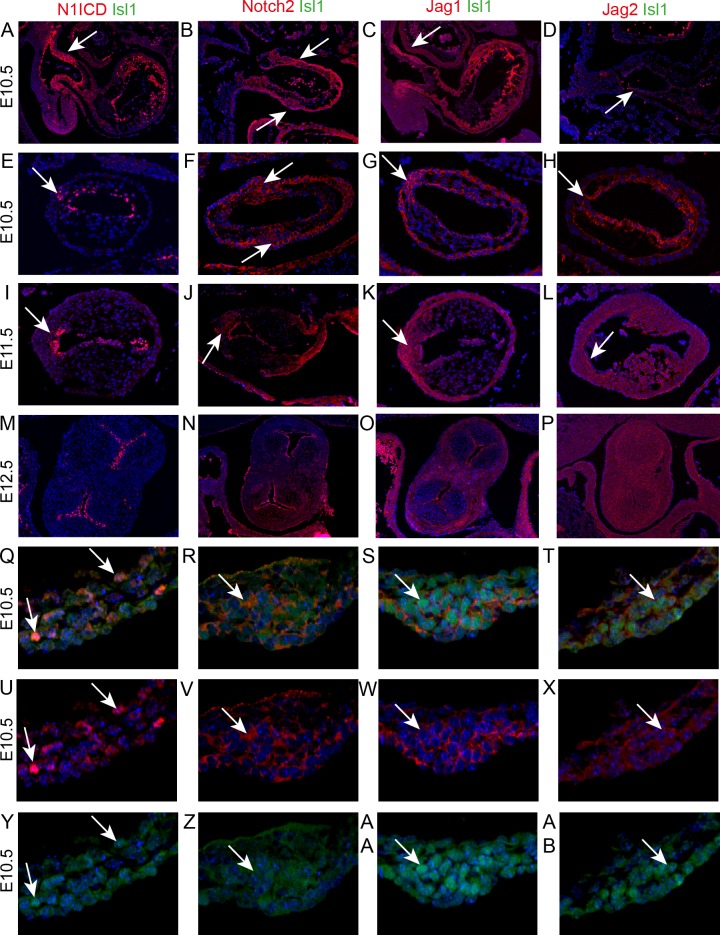
Notch signalling is found in the developing ICVS.All sections are frontal unless otherwise stated. Images are typical examples from a minimum of n = 3 at each stage. In E-AB, arrows point to the ICVS. (A–D) Sagittal sections show that Notch1ICD, Notch2 and Jag1 are abundant in the distal outflow wall (arrows) at E10.5. Jag2 is only found in the endothelium (arrow in D). (E–L) Notch1ICD, Notch2, Jag1 and Jag2 are found in the endocardium overlying the main cushions, but not within the cushions themselves at E10.5–11.5. All four localise to the ICVS at E10.5, with Notch1ICD, Notch2 and Jag1 maintained at E11.5. (M–P) Notch1ICD, Notch2 and Jag1 are found in the valve endothelium at E12.5, but none of these, nor Jag2, is found in the valve interstitial cells G-AB) Isl1 and Notch1ICD co-localise in the nuclei of only a few cells within the ICVS at E10.5, although Notch2, Jag1 and Jag2 are found in the membrane of Isl1 +nuclei containing cells in the core of the ICVS at this stage. Scale bar: A-D = 360 μm, E-H = 120 μm, I-L = 150 μm, M-P = 225 μm, Q-AB = 75 μm.